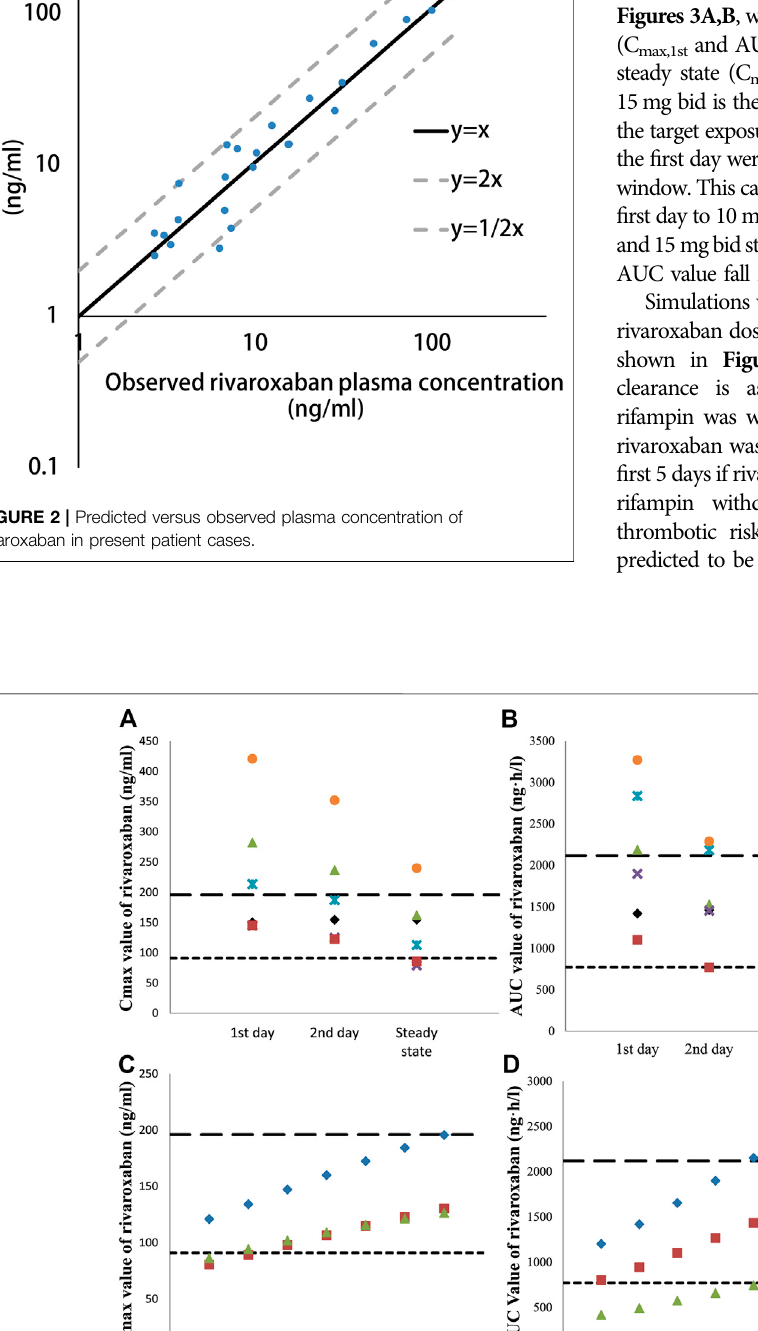
Frontiers in Pharmacology |